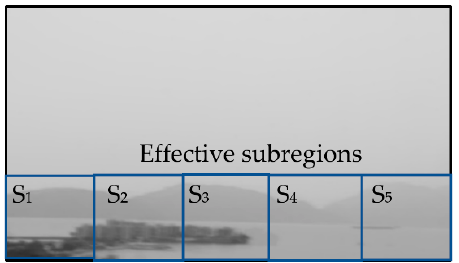
Figure 6. Comprehensive gray average image with subregions.